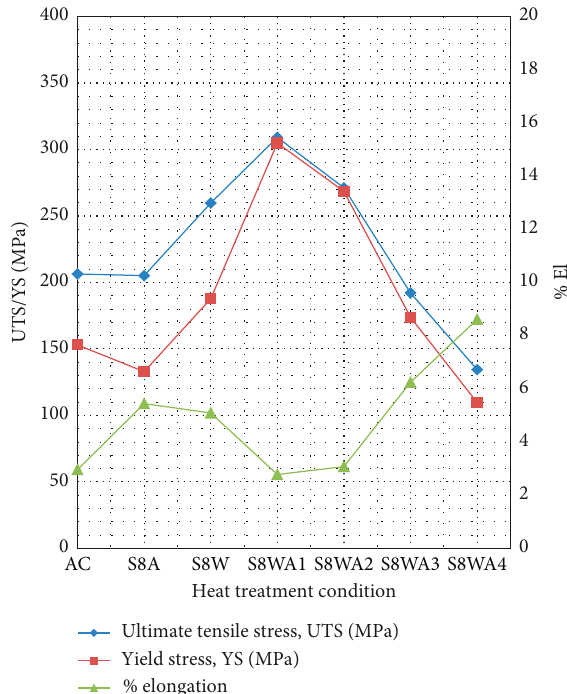
Figure 9: Average values of UTS, YS, and %El obtained at 250 ° C, for alloy D in the as-cast condition, and after heat treatments comprising SHT for 8h.